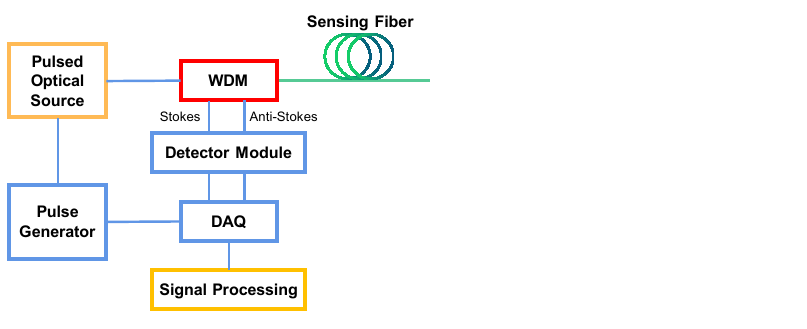
Figure 1. Schematic configuration of a generic ROTDR temperature sensor system. WDM, wavelength division multiplexer; DAQ, data